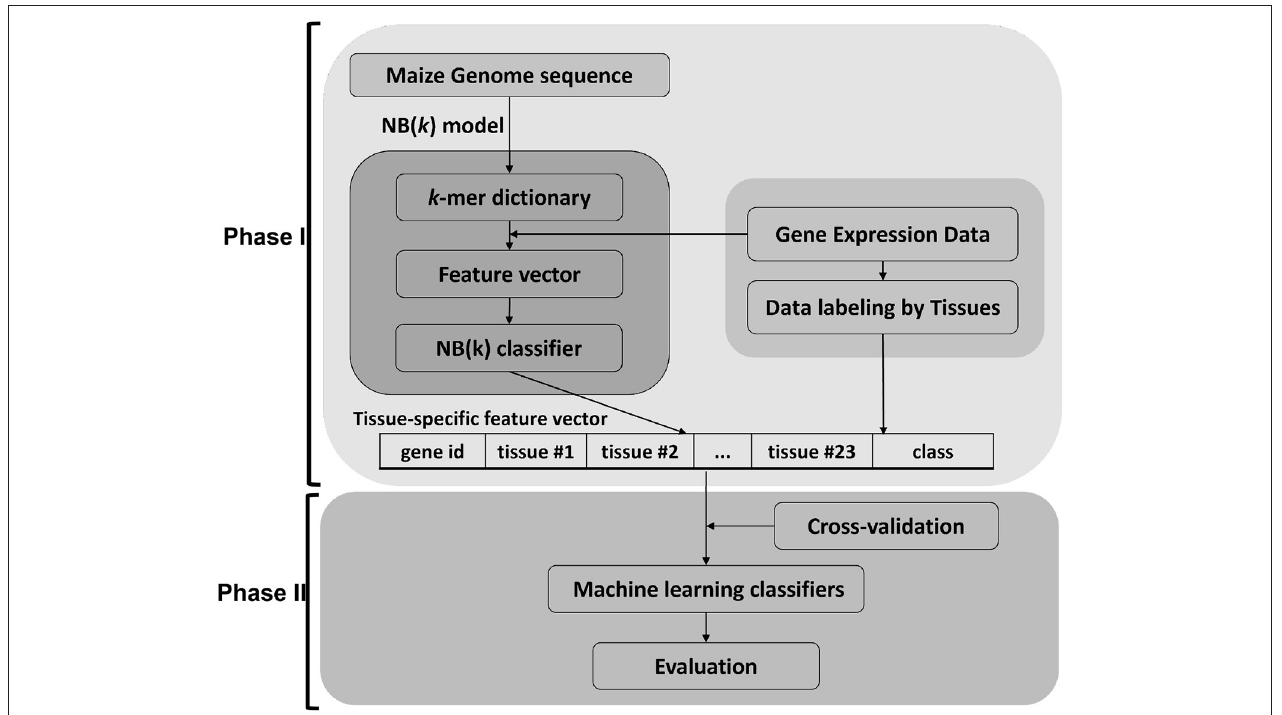
FIGURE 1 | Framework of t NB( k ) model. The approach for this paper is divided in two major parts. Phase I uses the NB( k ) implementation of a k − 1 Markov model to build classifiers that predict tissue-specific gene expression of genes based on k -mer subsequences of either DNA or protein. The results from each tissue-specific classifier were used to generate a new feature vector that was in turn used as input to a Phase II classifier. For the Phase II classifier we showed results for 5 common machine learning approaches, but other machine learning approaches could be applied in the second